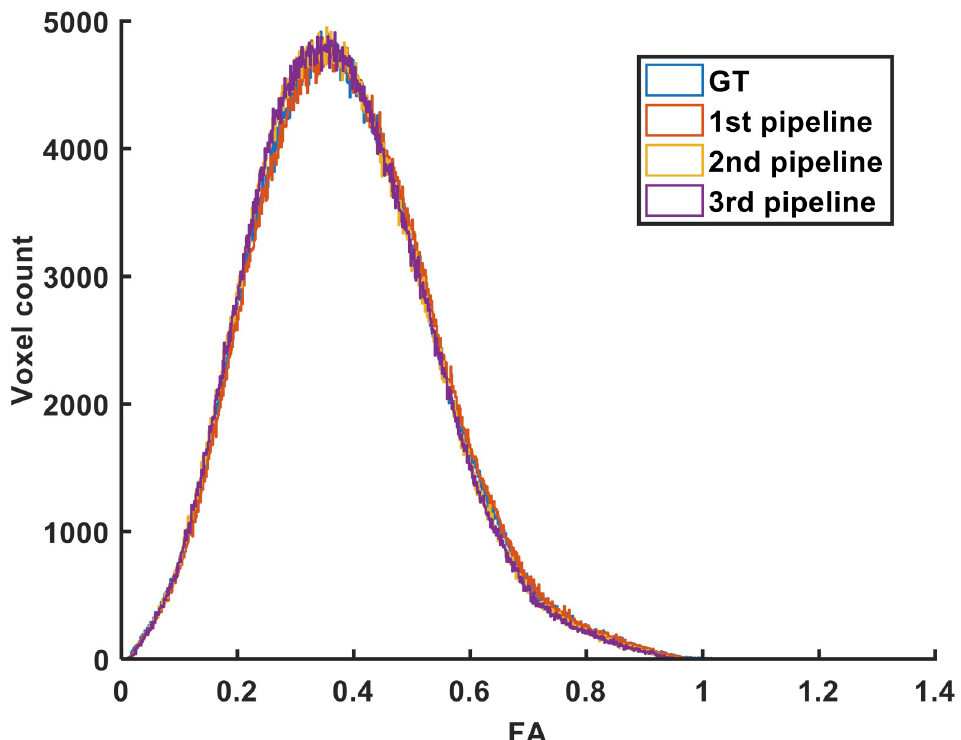
Fig 6. Distribution of FA values in the WM region generated by the three pipelines after processing the ground- truth data.